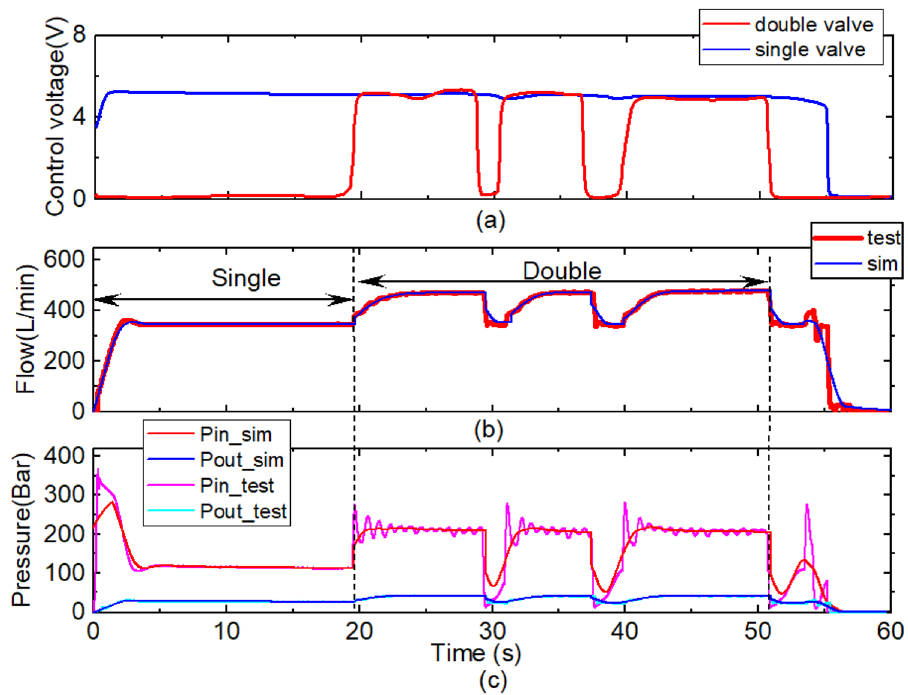
Fig. 5 Comparing results of flow and pressure in idle